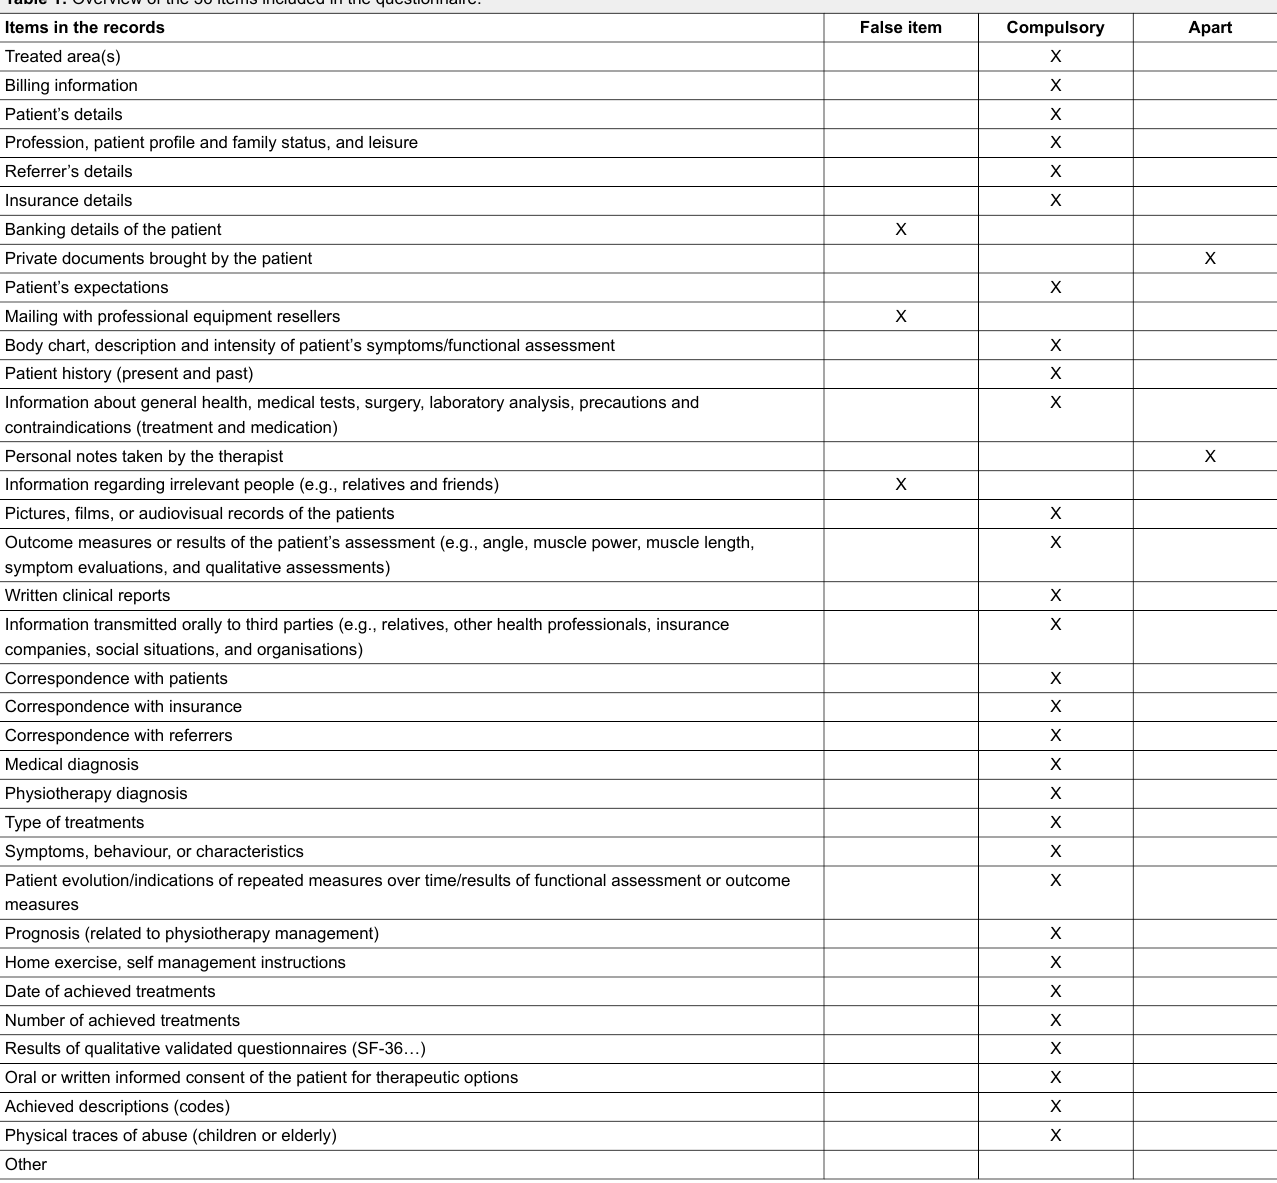
Table 1: Overview of the 36 items included in the